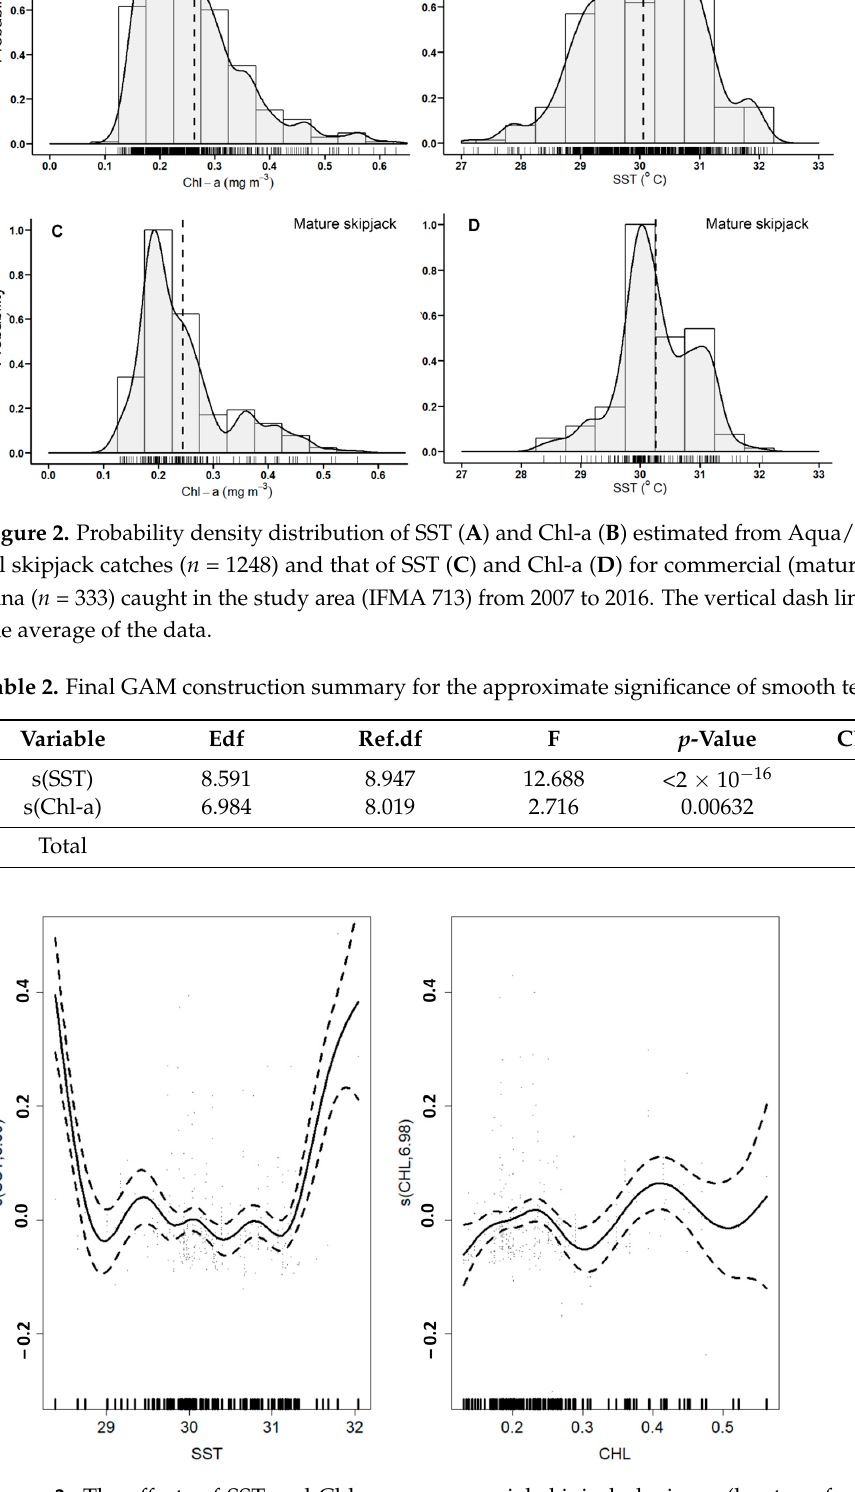
Figure 3. The effects of SST and Chl-a on commercial skipjack deviance (log-transformed) were determined using a generalized additive model (GAM). The model incorporates all explanatory variables (GAM). On the x -axis, the rug plot indicates the relative frequency of data points. The dashed lines signify 95% confidence levels.